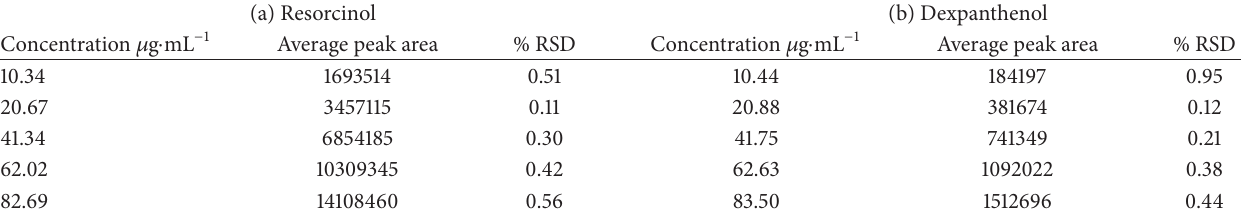
Table 2: HPLC linearity.